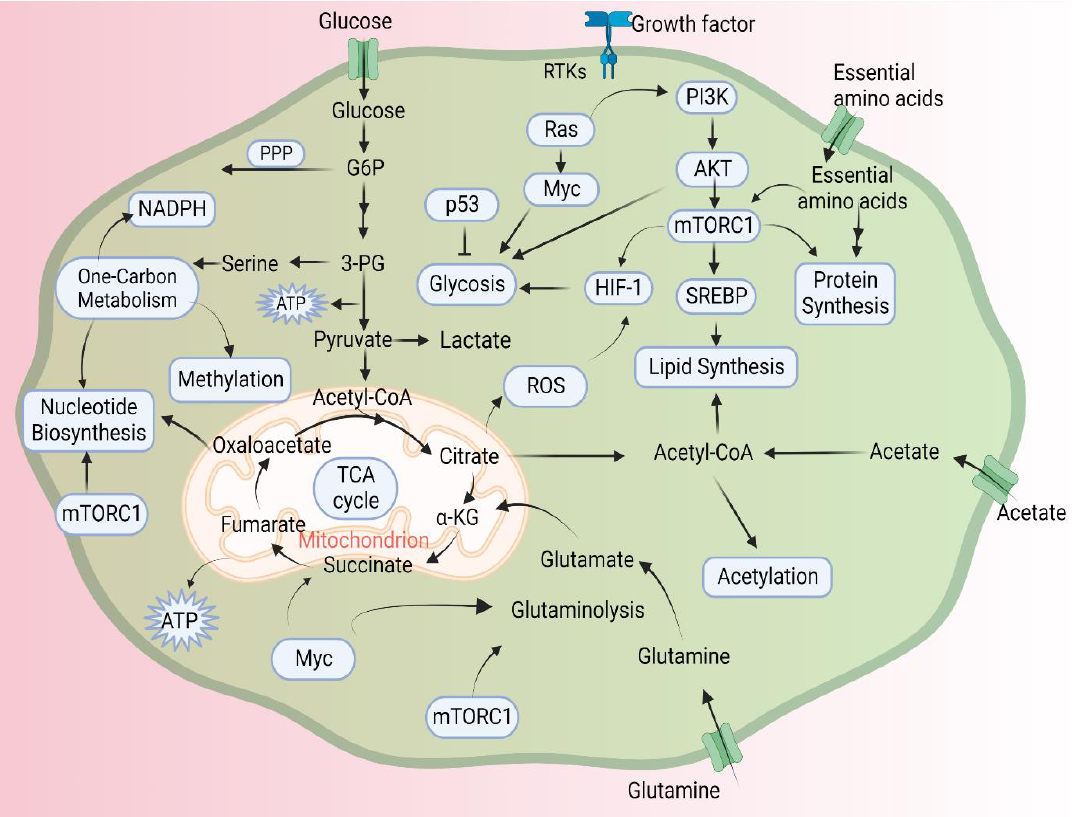
Figure 6. Signaling pathways involved in cancer cell metabolism. (Concept taken from [60] and created with BioRender.com. Last accessed 22 January 2023).